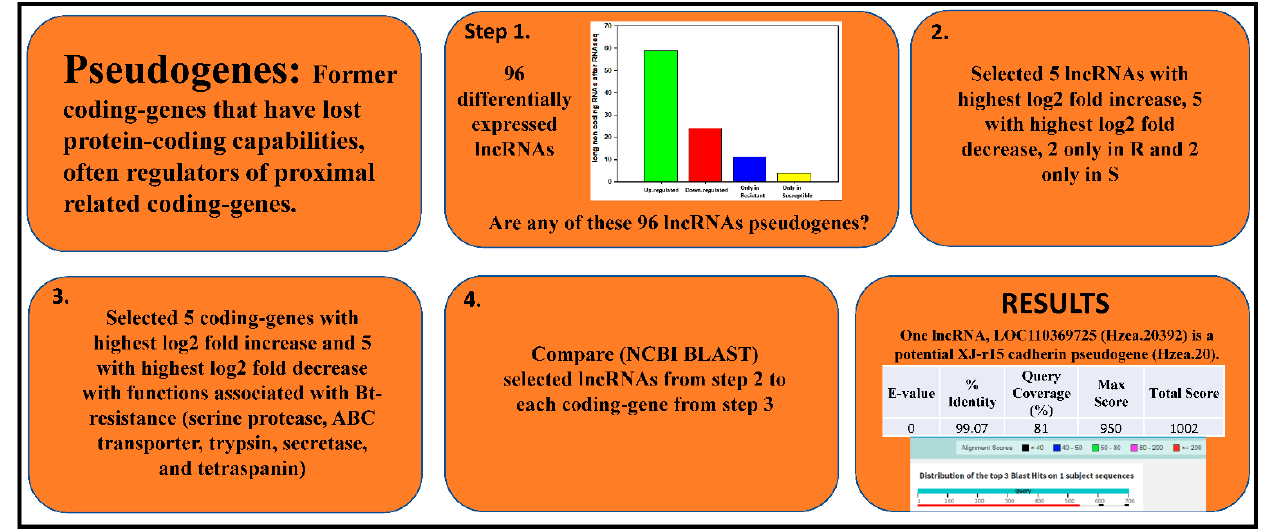
Figure 2. Workflow to identify statistically differentiated lncRNAs as putative pseudogenes.